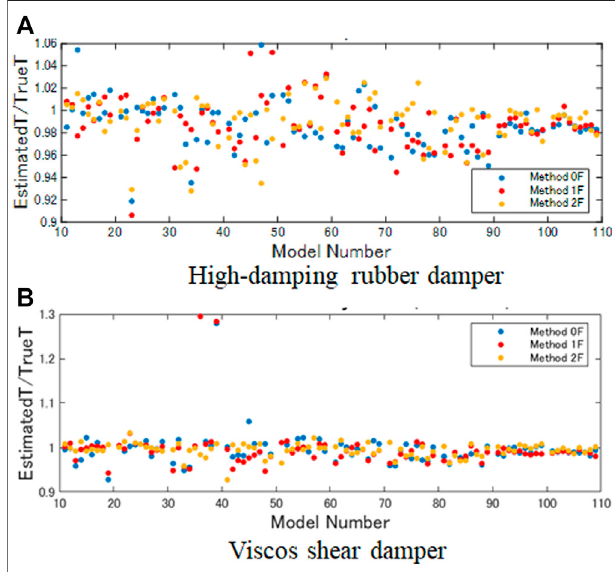
FIGURE 5 | Tension estimation results for cases with measurement error: (A) high-damping rubber damper; (B) viscos shear damper.